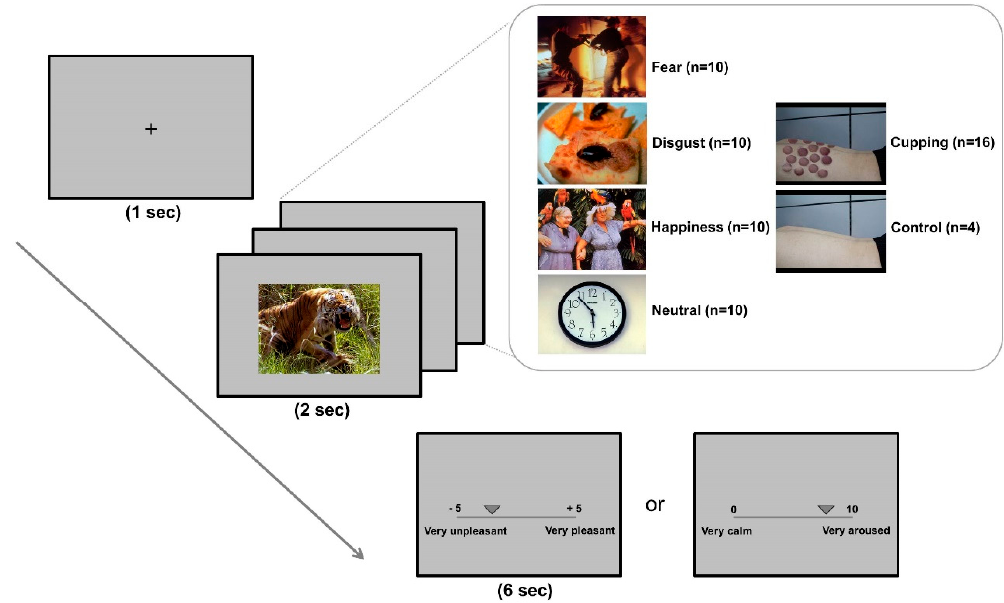
Figure 1. Experimental design. Four di ff erent kinds of a ff ective images (fear, disgust, happiness, neutral) were taken from the International A ff ective Picture System (IAPS). The cupping therapy images included images of several circular body areas with patches of redness, petechiae and ecchymoses, or bruising. Control images of body areas were matched as closely as possible for visual characteristics (e.g., colour, brightness, background scene). At the start of each trial, a fixation cross was displayed in the centre of the screen for 1000 ms. The fixation cross was followed by emotional stimuli, including IAPS and cupping therapy images, which were displayed for 2000 ms. After the presentation, participants were given 6000 ms to evaluate the valence and arousal level of each emotional stimulus.